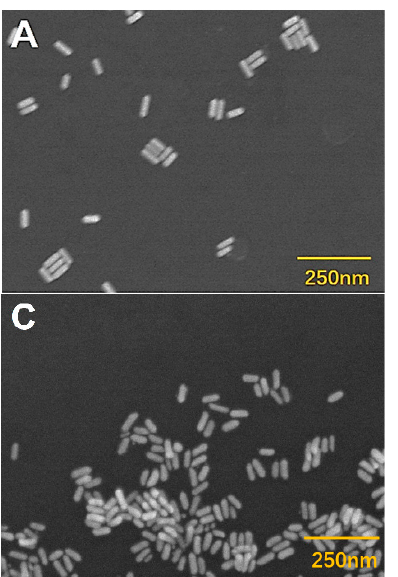
cess, the dynamic light scattering (DLS) particle size distribution was checked (Figure etched silver-coated gold nanorods were only about 125 nm (Figure 4B). For the same the original silver-coated gold nanorods (Figure 4C), which proved the etching process. Herein, the DLS sizes were greater than the sizes obtained from SEM image because the